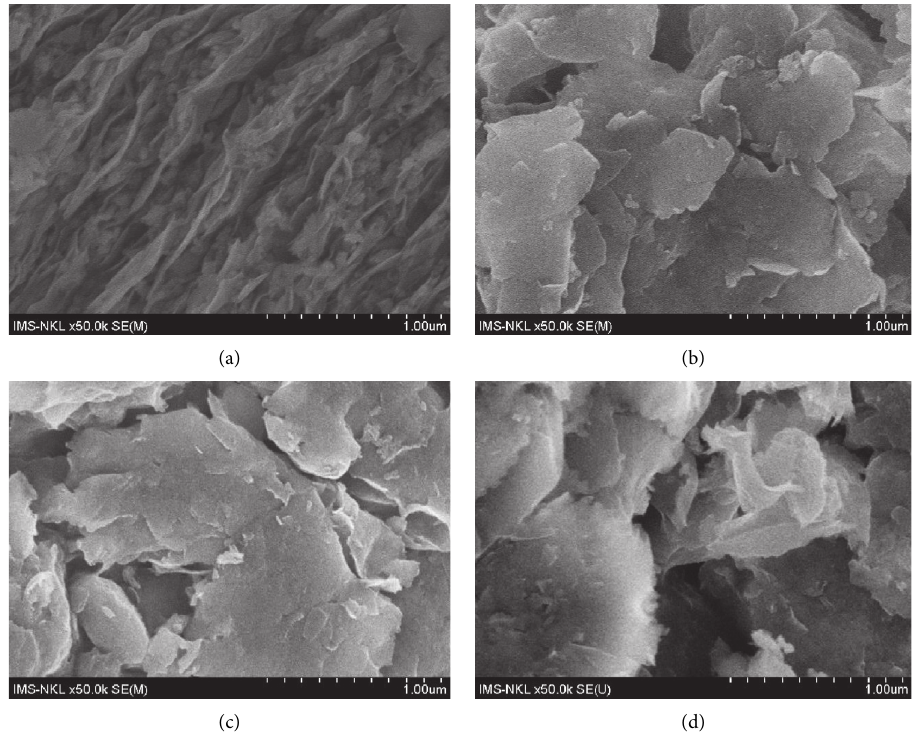
Figure 5: SEM micrographs of B (a), CB (b), AlCB (c), and FeCB (d).